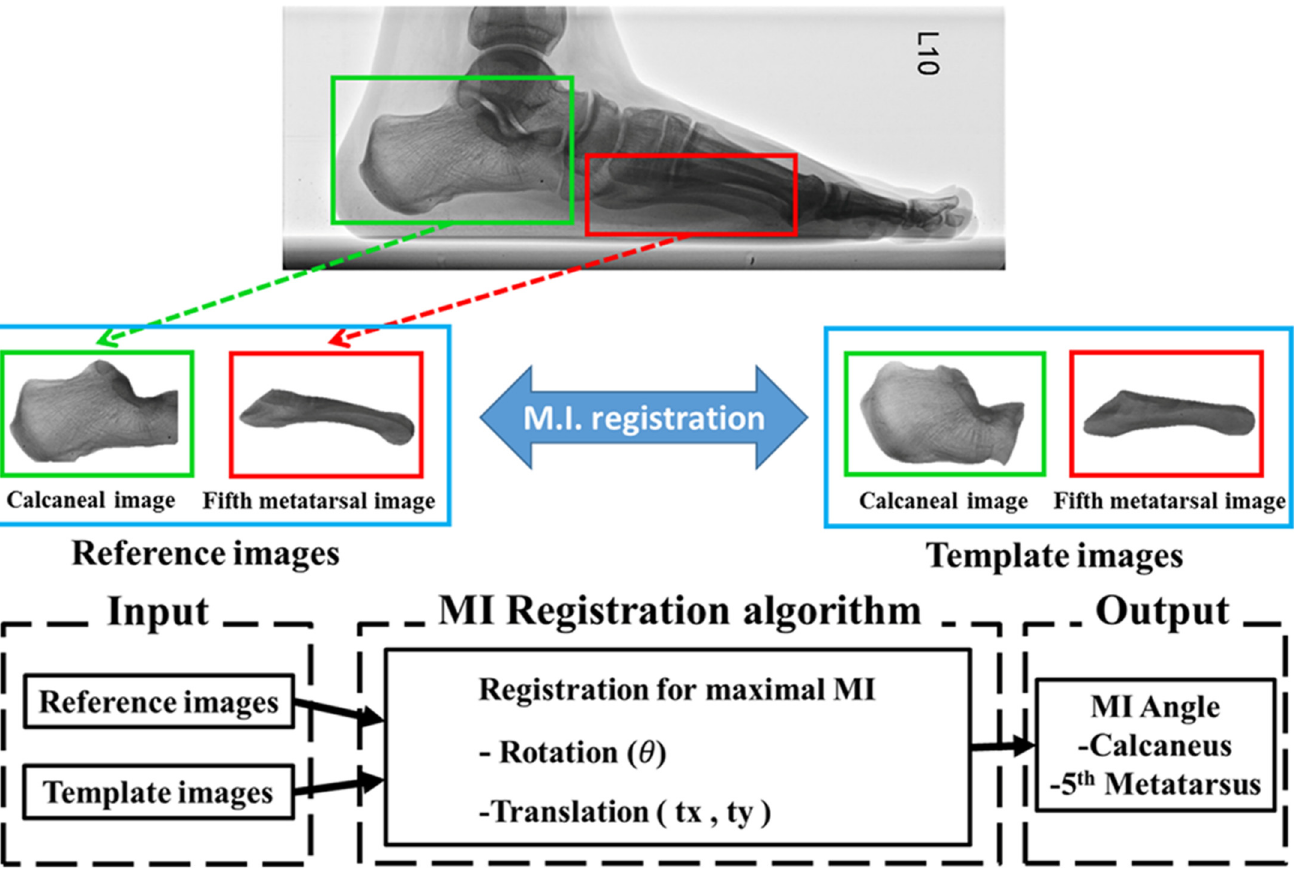
Fig 4. Flowchart of the methodology of the mutual information (MI) registration algorithm. The images were converted into two-dimensional image parameters ( θ , tx , ty ). Image registration was achieved after repeated calculation until the MI between the template and the reference images was